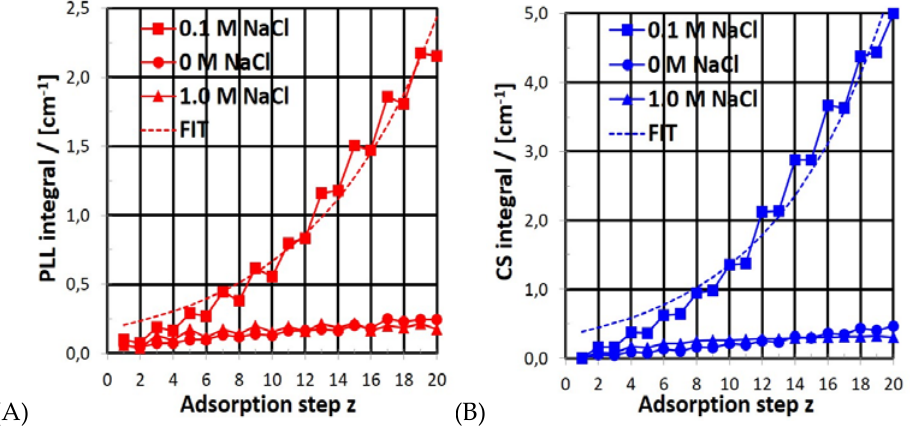
Figure 3. Variation of band integrals A PLL (red, A ) and A CS ( B , blue) related to the in situ ATR-FTIR spectra given in Figure 2 in relation to z = 1–20) at c PEL = 0.01 M and pH = 7.0 for c S = 0, 0.1 and 1.0 M.